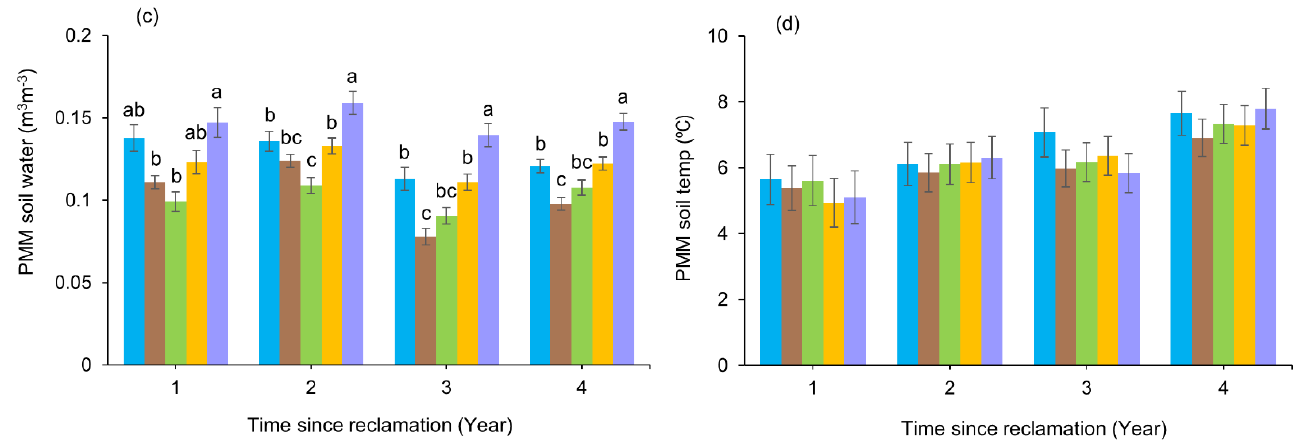
Figure 4. ( a – d ) Mean annual soil water content and temperature by cover soil type at the research sites. Different letters indicate significant differences at p = 0.05 in Tukey HSD post hoc comparisons. FFM = forest floor mineral soil mix; PMM = peat minerals soil mix; L = large diameter (>15 cm); S = small diameter (2–4.9 cm).